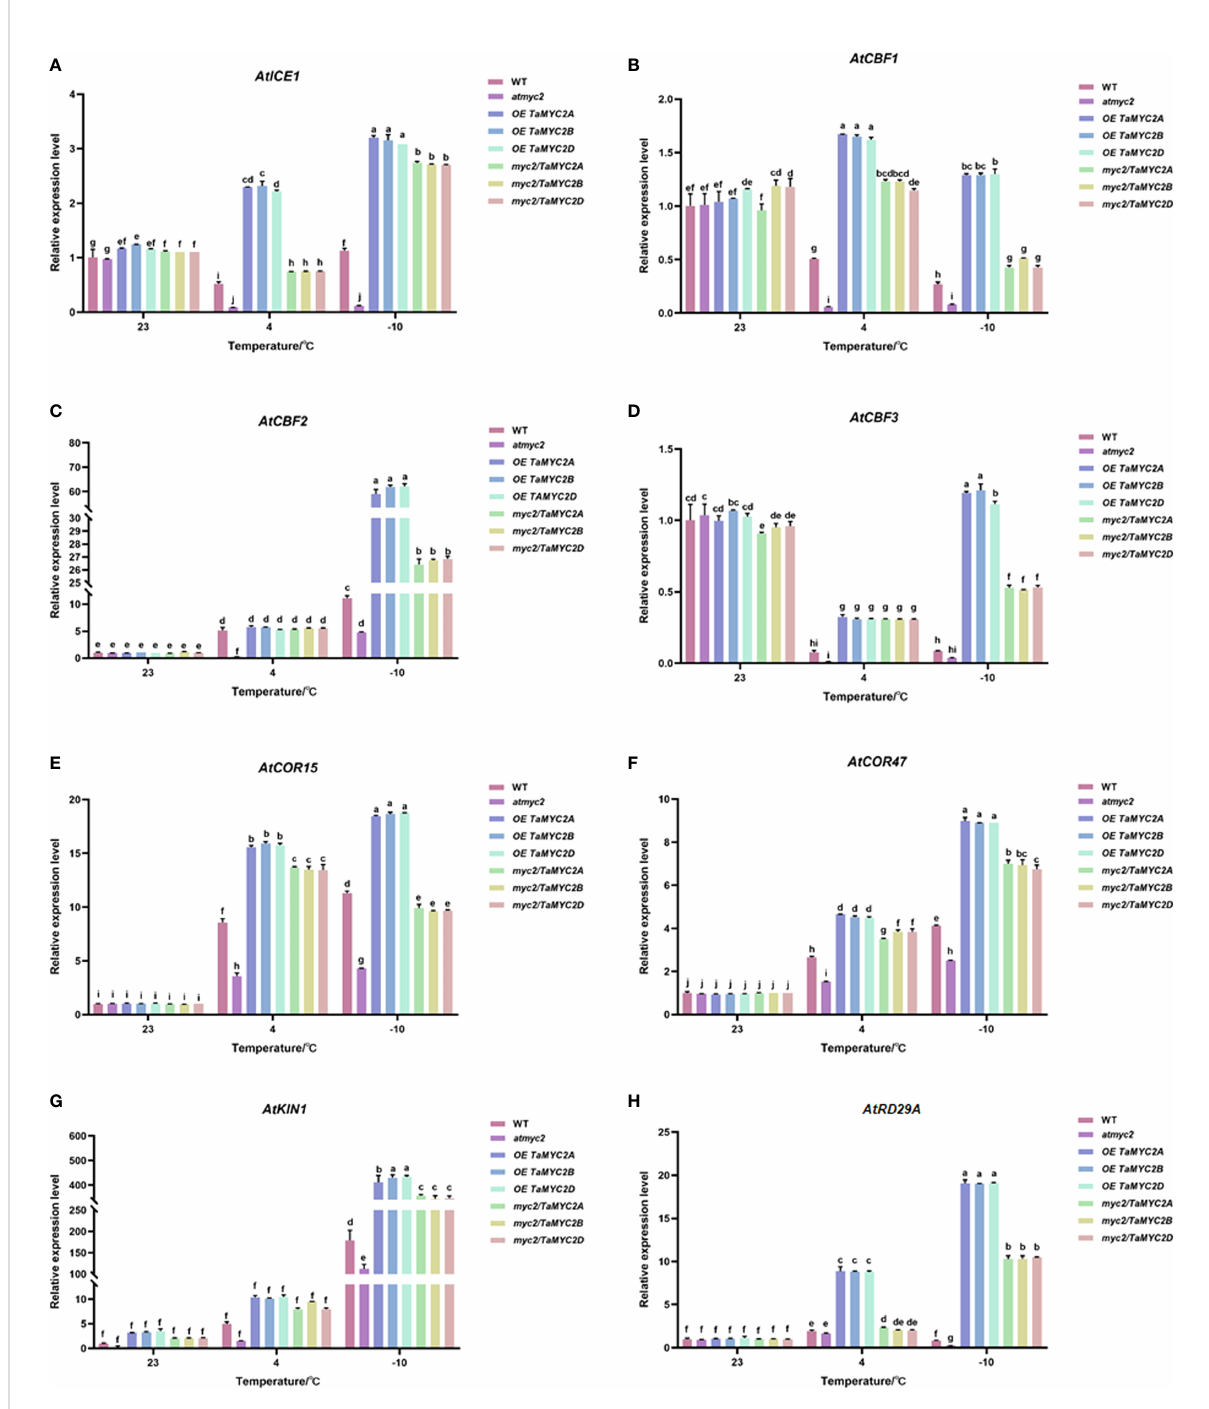
FIGURE 5 Effects of TaMYC2 on the ICE-CBF-COR module in Arabidopsis under cold stress. Expression of (A) AtICE1 , (B) AtCBF1 , (C) AtCBF2 , (D) AtCBF3 , (E) AtCOR15 , (F) AtCOR47 , (G) AtKIN1 , (H) AtRD29A in WT, atmyc2 mutants, and transgenic Arabidopsis under low temperature stress. The top to bottom on the right side of each bar chart corresponds to the left to right sides of the same temperature. The error lines were obtained from three biological replicates. The mean values of the experimental data were analyzed by one-way ANOVA analysis. The comparison method was the least signi fi cant difference (LSD), and the bar graphs with different letters indicated signi fi cant differences ( p <